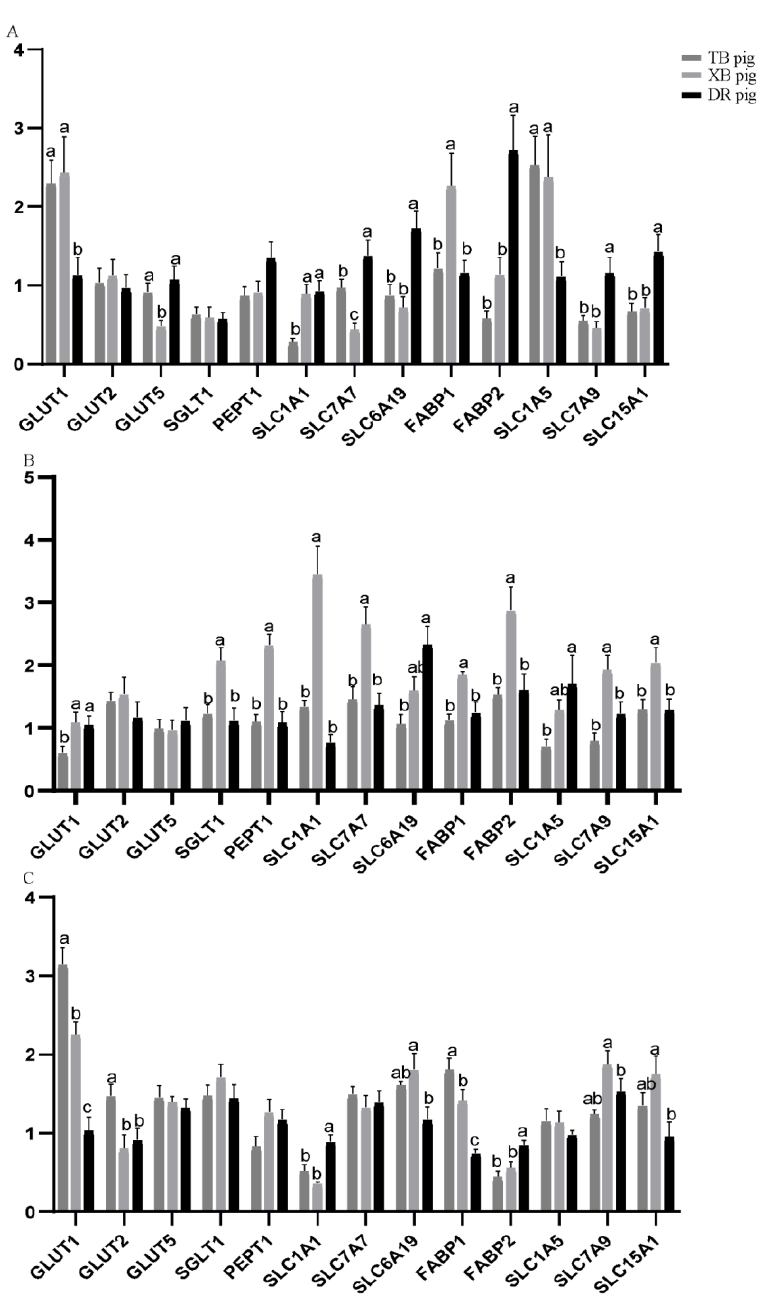
Figure 1. Nutrient transporter gene expression levels in the jejunum of three pig breeds at different ages ( n = 8): ( A ) 80 days of age; ( B ) 125 days of age; ( C ) 185 days of age. a,b,c Different letters indicate a significant difference ( p < 0.05). TB pig, Taoyuan black pig; XB pig, Xiangcun black pig; DR pig, Duroc pig; FABP , fatty acid binding protein; GLUT , glucose transporter; PEPT1 , peptide transporter 1; SGLT1 , sodium–glucose linked transporter 1; SLC1A1 , solute carrier family 1 member 1; SLC1A5 , solute carrier family 1 member 5; SLC6A19 , solute carrier family 6 member 19; SLC7A7 , solute carrier family 7 member 7; SLC7A9 , solute carrier family 7 member 9; SLC15A1 , solute carrier family 15 member 1. The figure below is the